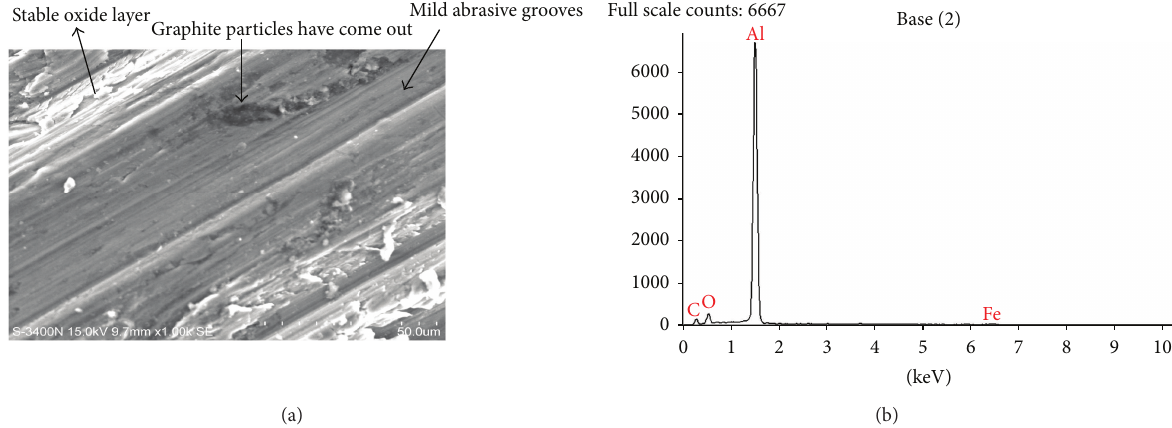
Figure 13: (a) SEM and (b) EDX analysis of worn surface of Al + 6% graphite; load-10 N.